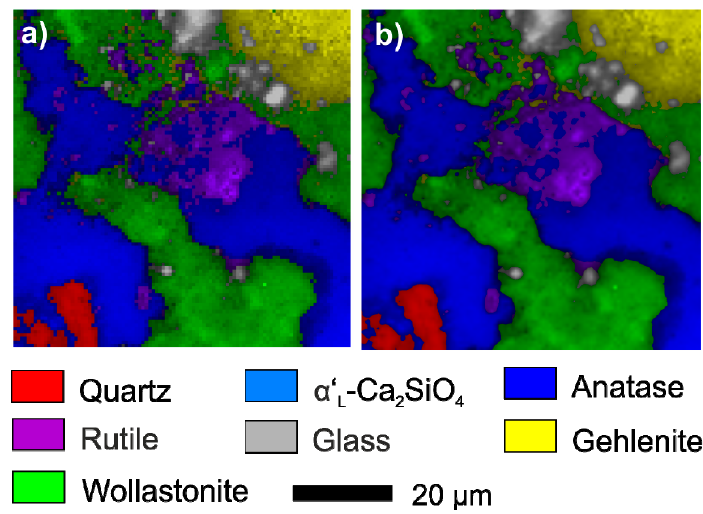
Figure 6. The effect of image smoothing on a hyperspectral Raman image of a sintered ceramic (Kln 60 Qtz 15 Cal 25 , T max = 1097 ◦ C). ( a ) unsmoothed and ( b ) smoothed image. Note that in particular grain boundaries are better displayed in the smoothed